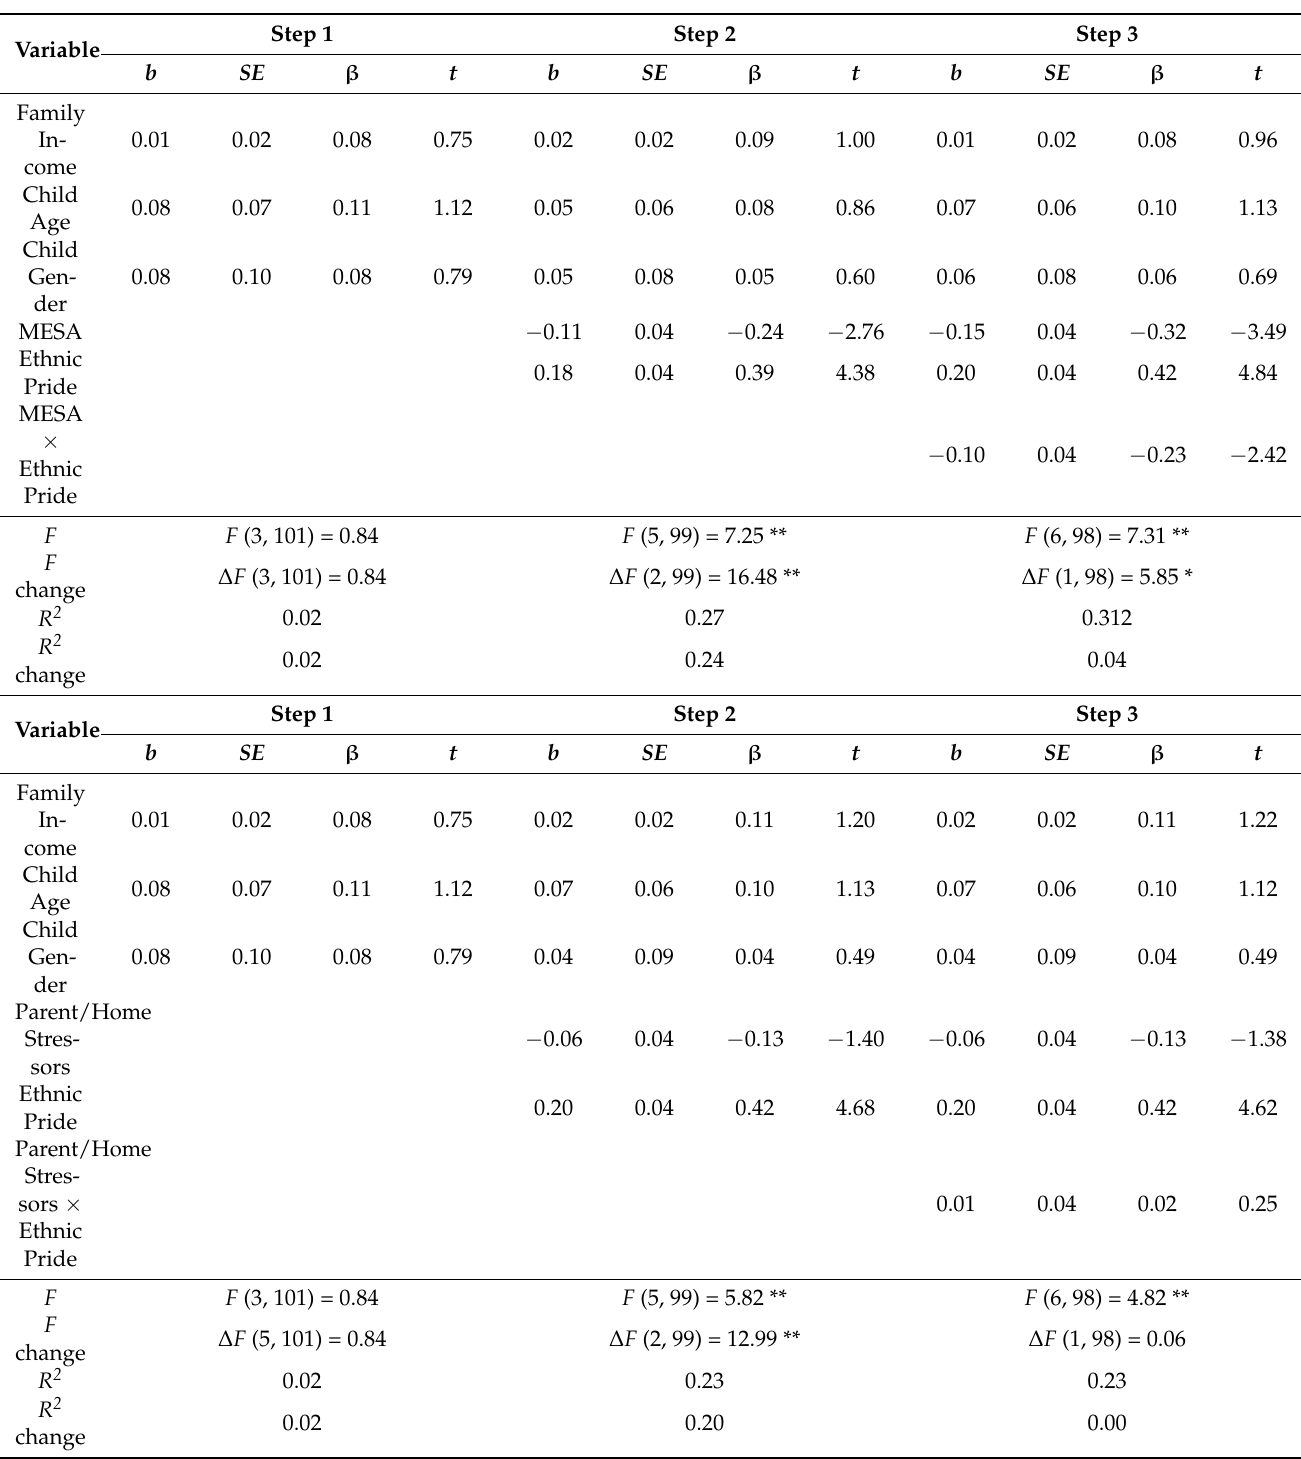
Table 5. Moderated regression analysis of the role of ethnic pride on child